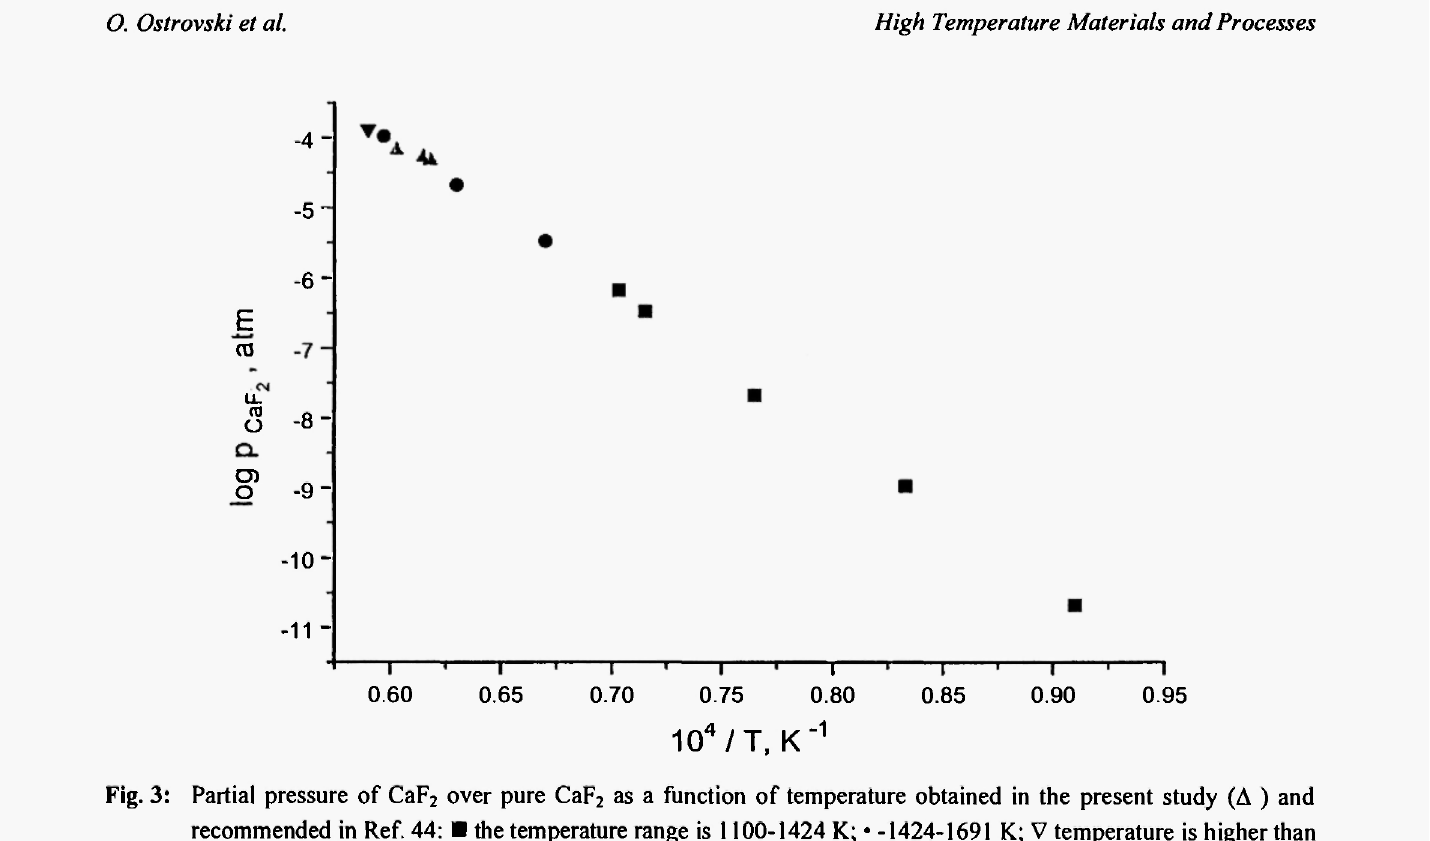
Partial pressure of CaF 2 over pure CaF 2 as a function of temperature obtained in the present study (Δ ) and recommended in Ref. 44: • the temperature range is 1100-1424 K; · -1424-1691 Κ; V temperature is higher than